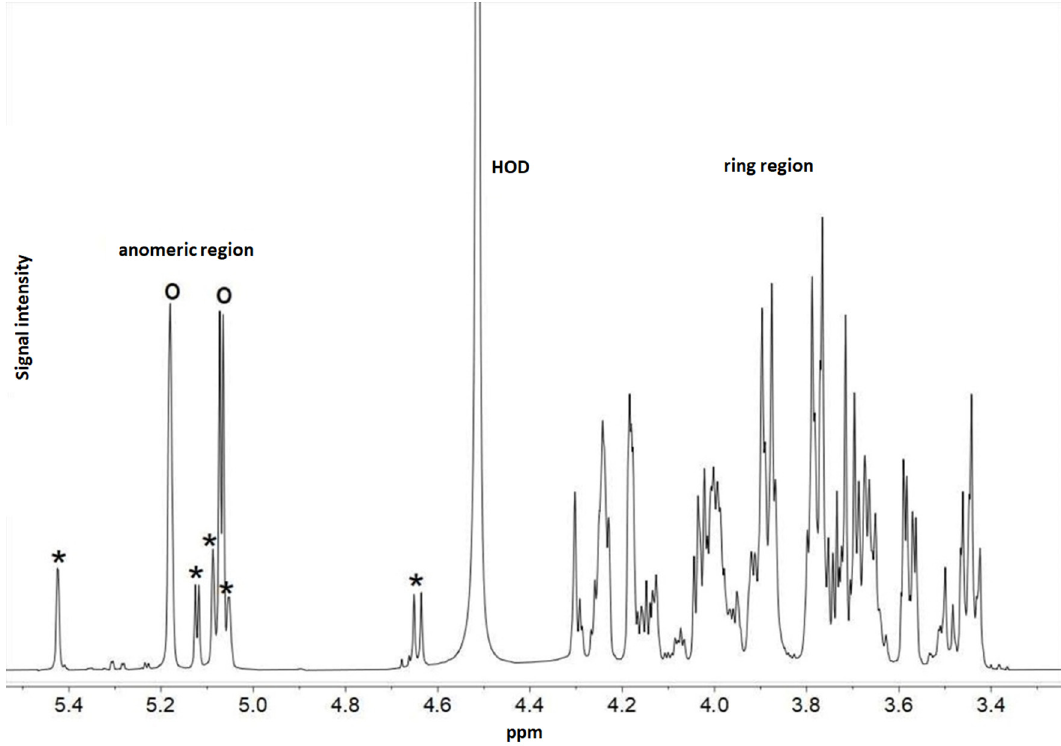
Figure 8. 1 H NMR spectrum of MC1 EPS-b recorded in D 2 O at 500 MHz at 50 °C. Protons of the ring and anomeric regions are shown. Open circles (o) denote the two most intense anomeric resonances belonging to the main polysaccharide, while asterisks (*) indicate the five less intense anomeric peaks, indicating another polymer present in minor amounts.